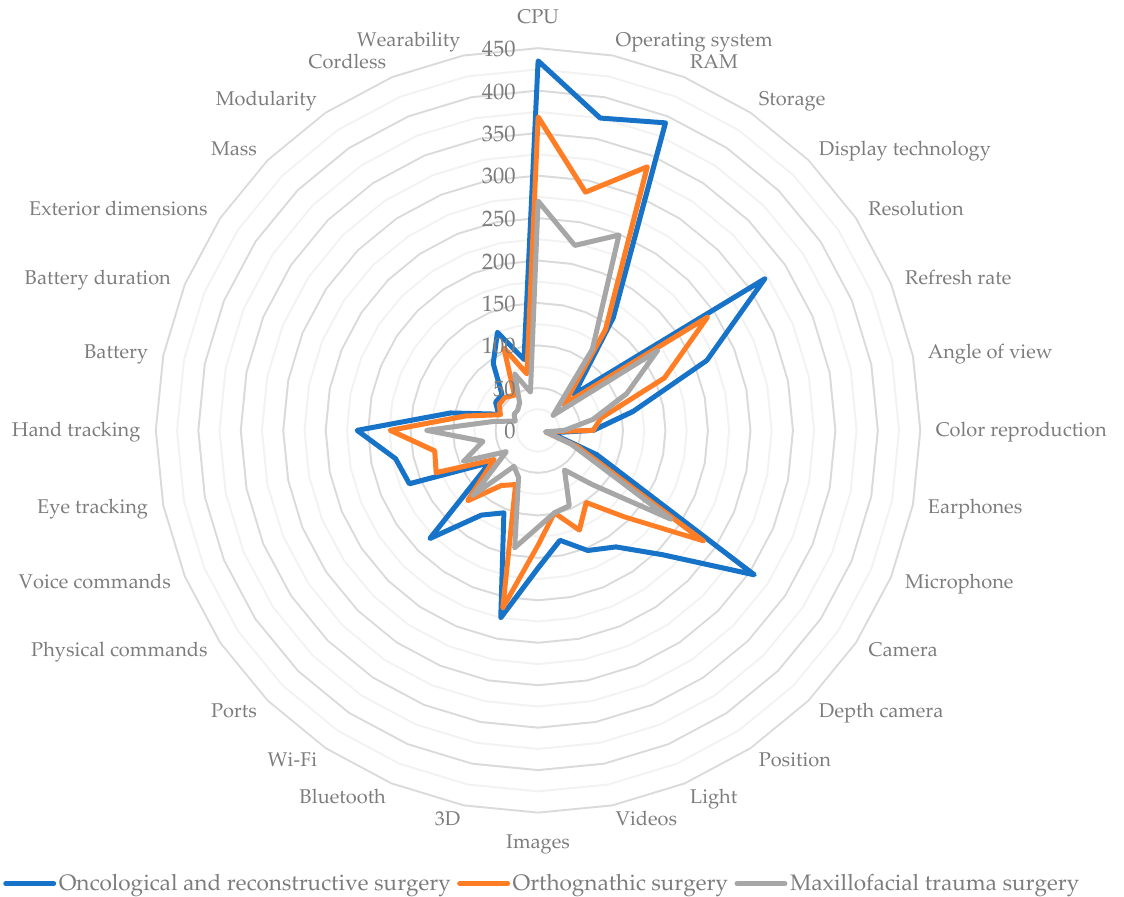
Figure 8. Specification relative importance comparison for the three analysed scenarios.